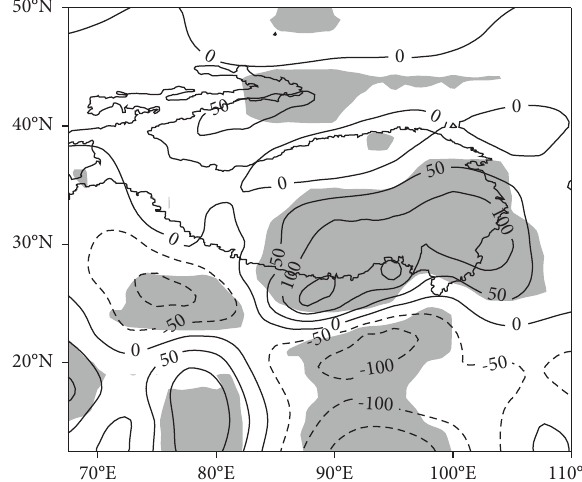
Figure 4: Diference synthetic feld of < Q 1 > of strong AHS/weak westerly-monsoon year and weak AHS/strong westerly-monsoon year (shadow indicates passing 95% reliability test, unit: w/m 2 ).